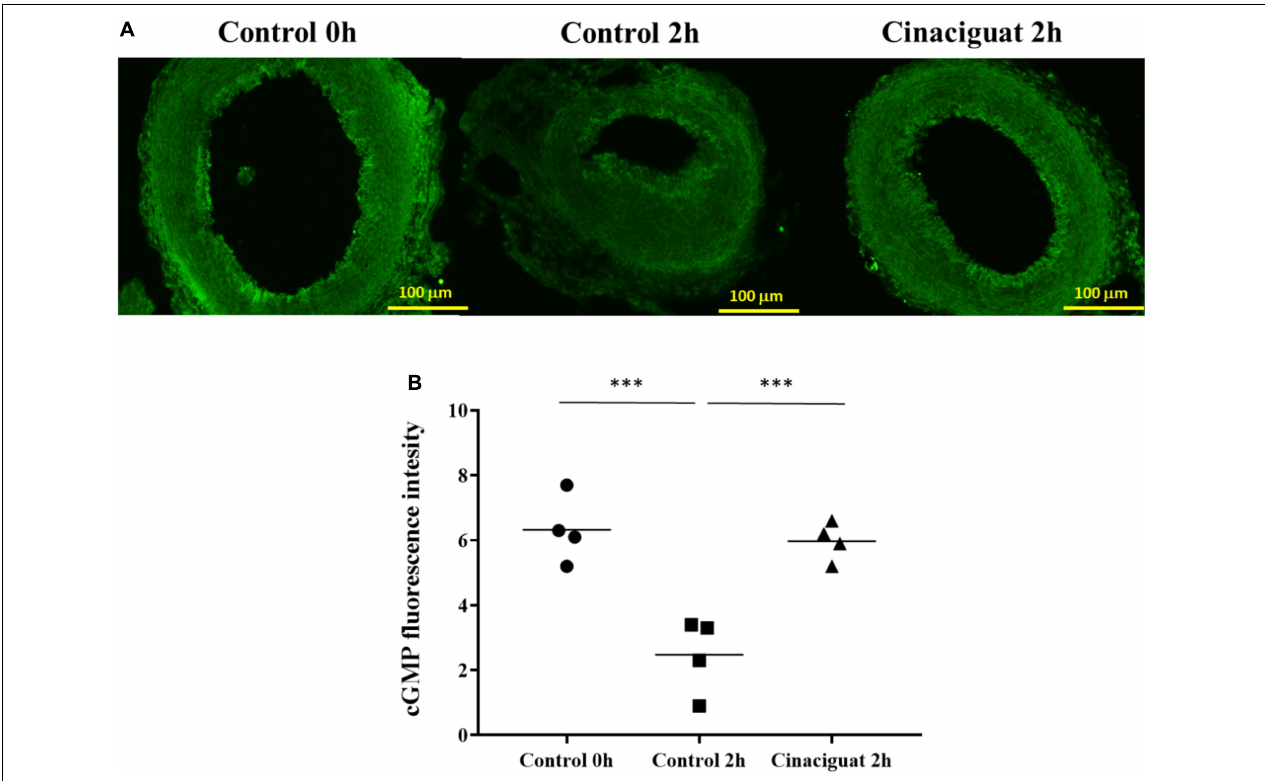
FIGURE 3 | Cinaciguat prevented ductus arteriosus (DA) closure and intimal thickening with associated preservation of cGMP in neonatal rats. (A) Representative immunofluorescence images of cGMP. (B) cGMP expression levels in DA in all groups. Values are presented by the dot plot with the mean. N = 4. ANOVA P < 0.05; *** P < 0.001; magnification 200 ×